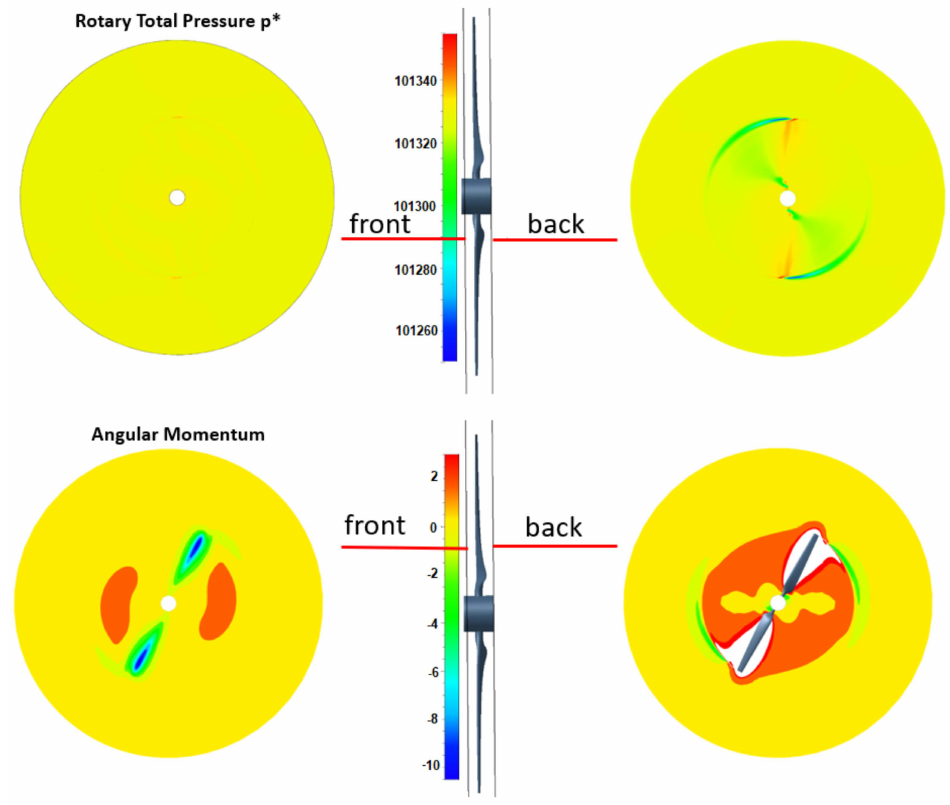
Figure 39. Rotary total pressure and angular momentum very close to the front and back of the wind turbine rotor, demonstrating that rothalpy is not constant. A viscous power loss exists in the shaft